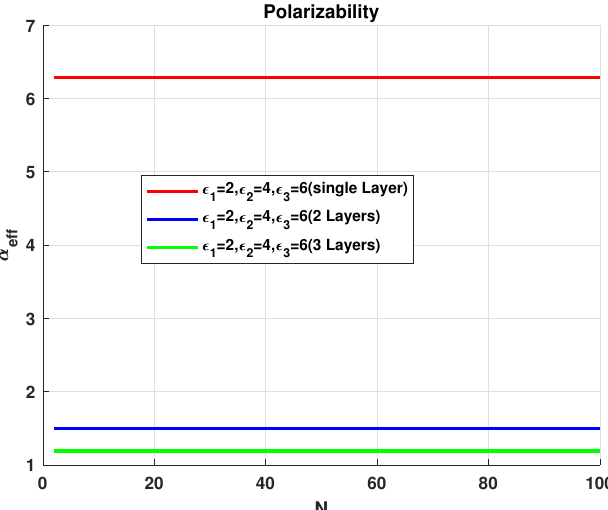
Figure 2. Normalized polarizability of isotropic core surrounded by the Spherically Radially Anisotropic (SRA) layers as a function of N number of layers, with the following parameters: ε 1 = 2; ε 2 = 4; ε 3 = 6; and anisotropic ratio is ν 1 = 1 and ν 2 =